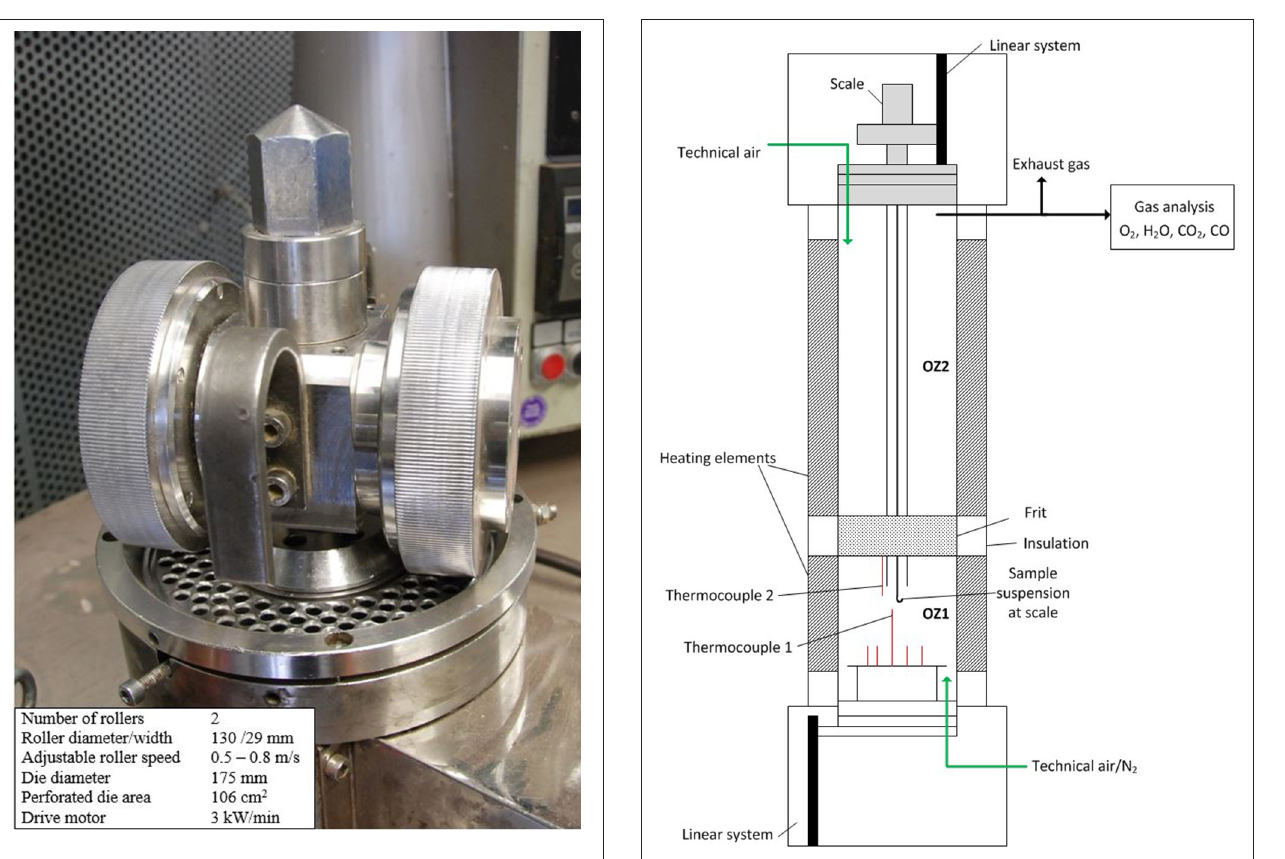
FIGURE 2 | Schematic layout of the used Large-scale Oven for Kinetic Investigations